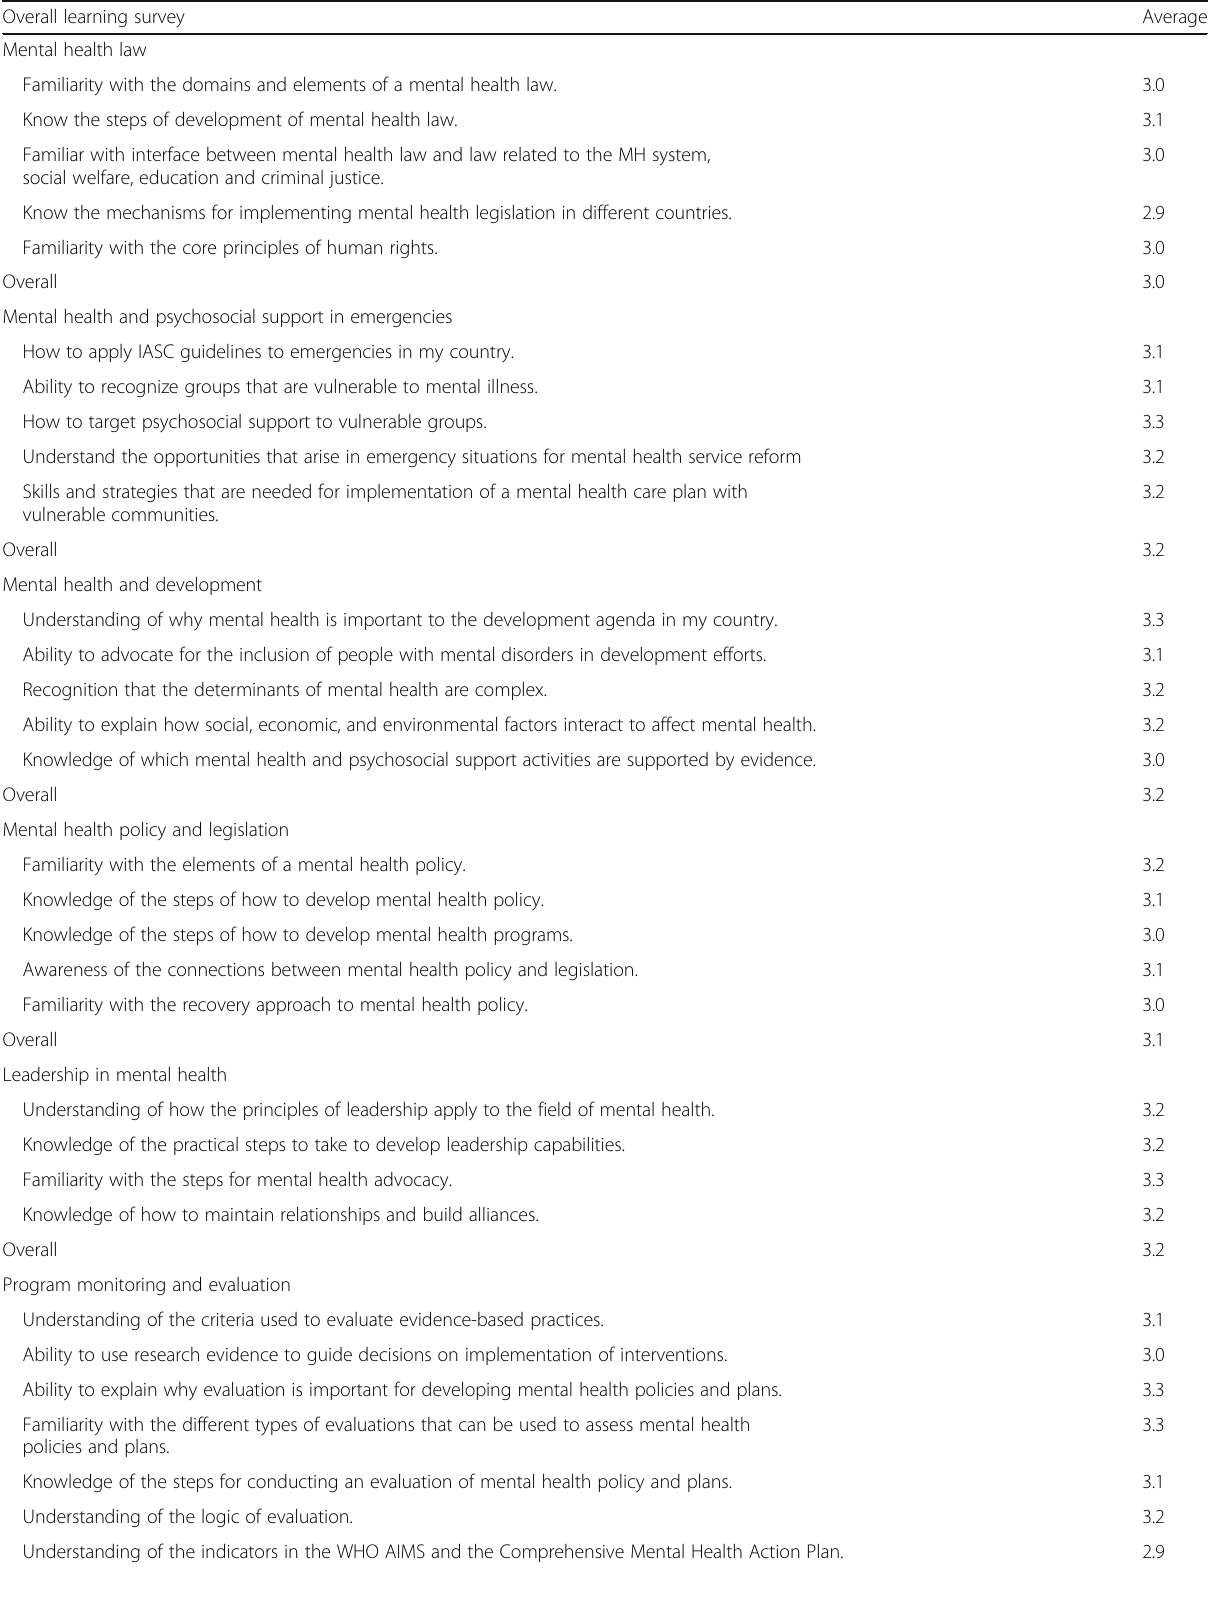
Table 3 Overall learning survey Overall learning